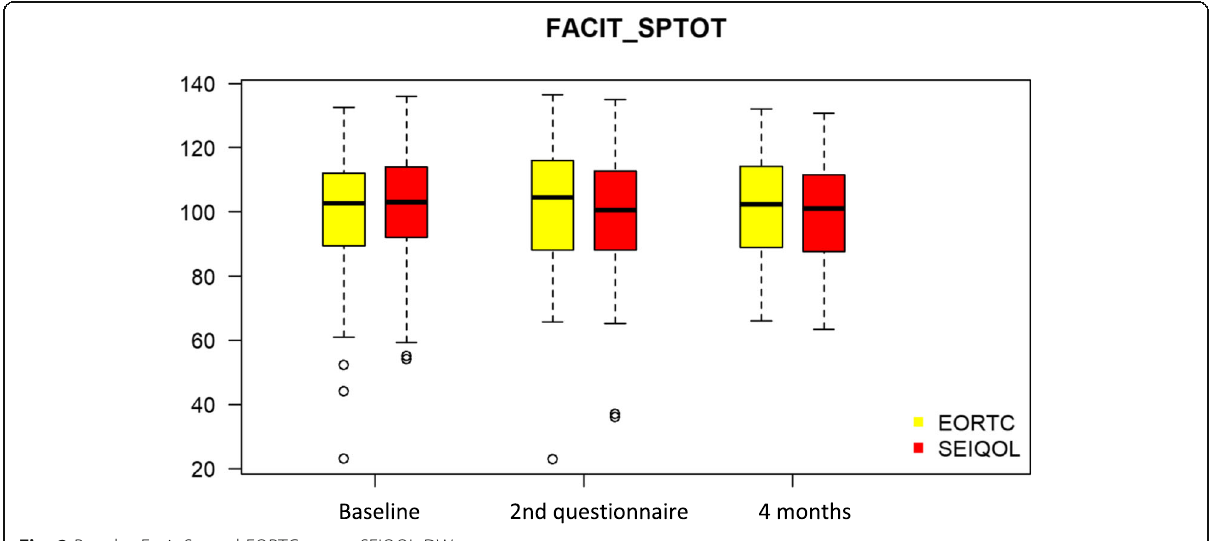
Fig. 2 Boxplot Facit-Sp and EORTC versus SEIQOL-DW